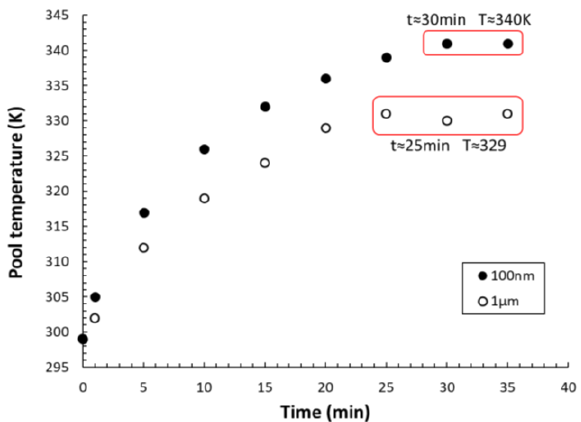
Figure 10. The temperature rise during the acoustic cavitation experiments at the applied frequency of 40 kHz.